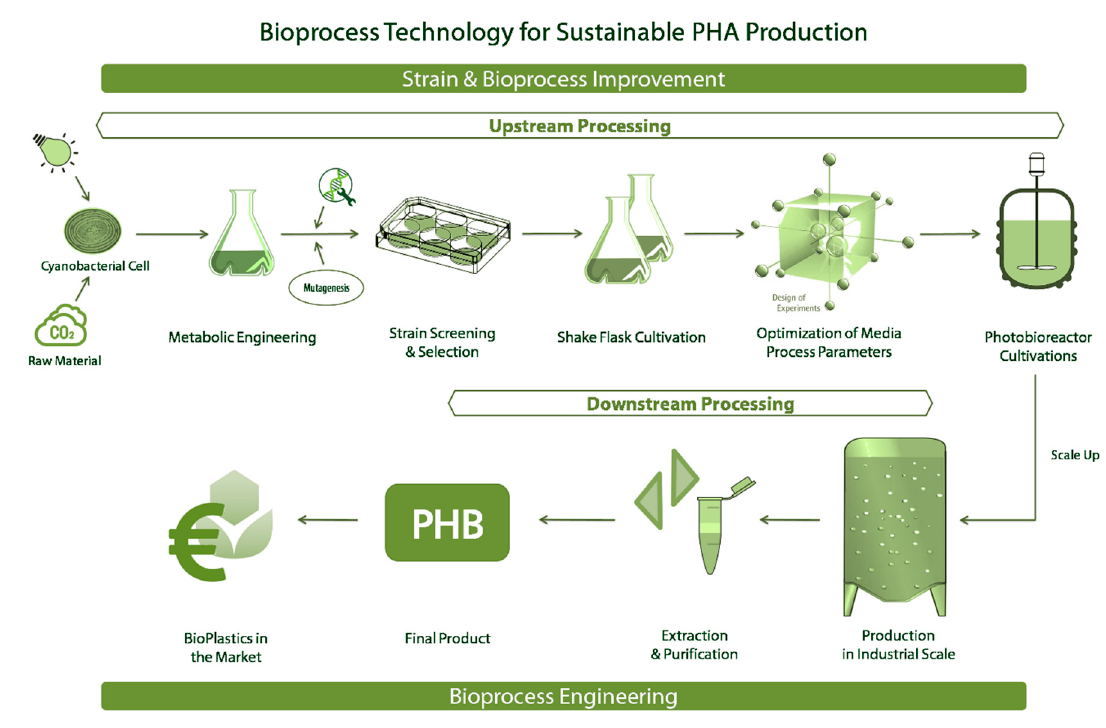
Figure 1. Represents the work-flow in bioprocess technology for the production of polyhydroxyalkanoates (PHAs) using cyanobacteria as the host system.